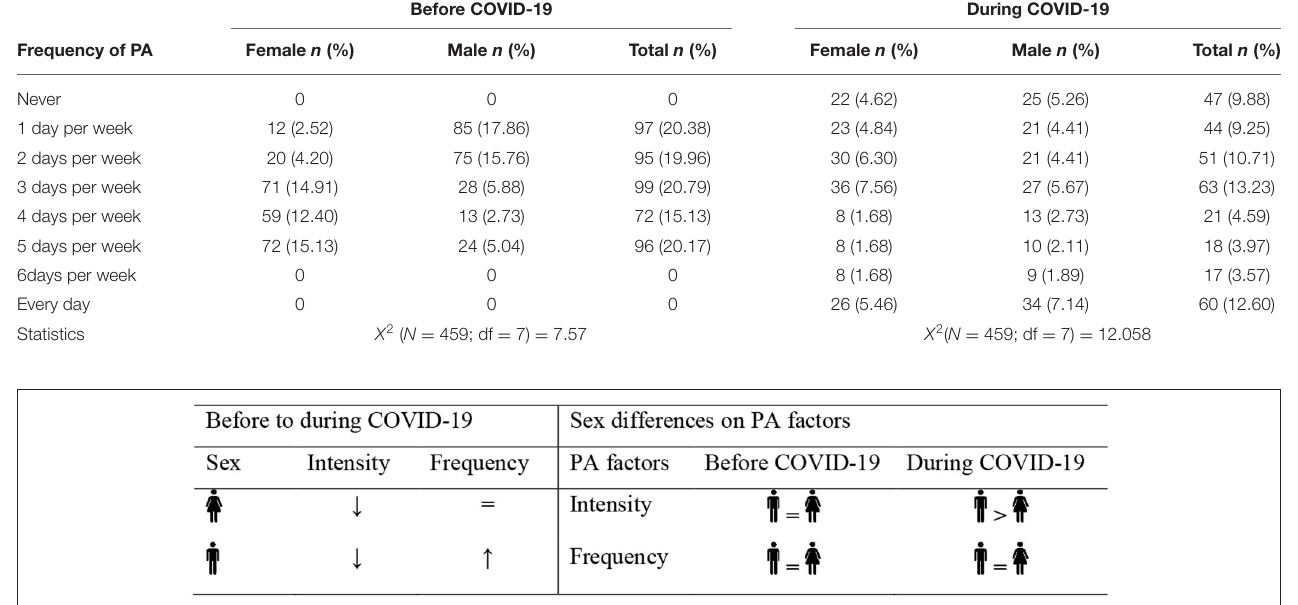
TABLE 3 | Frequency of PA before and during COVID-19, and separately for female and male participants. Before COVID-19